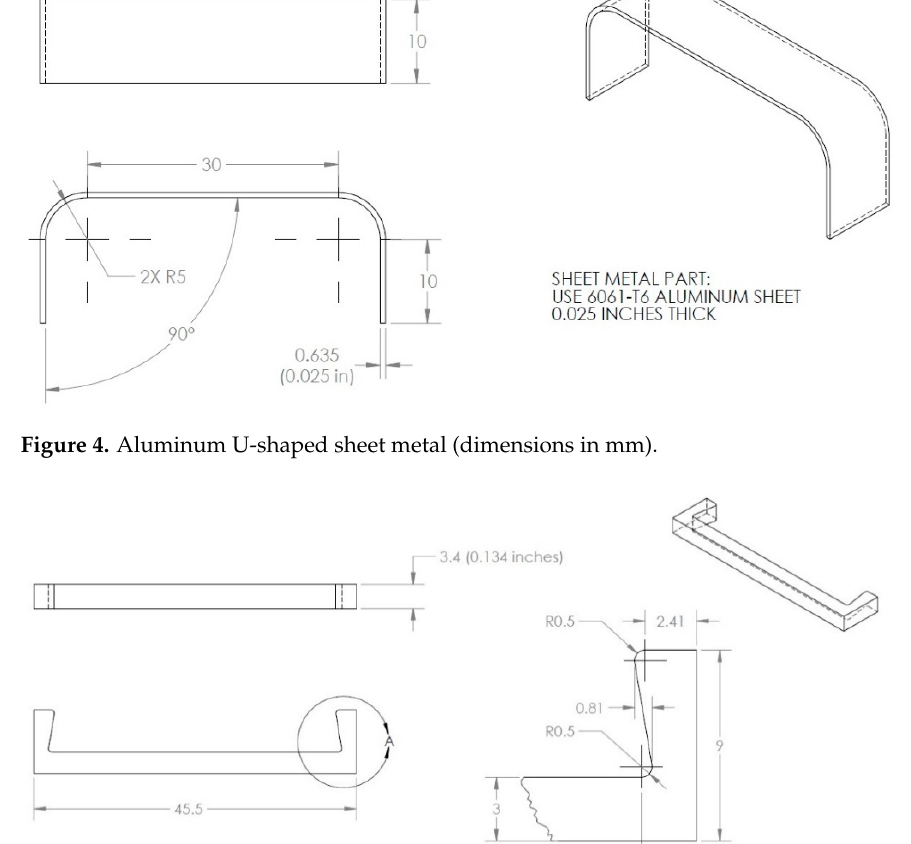
Figure 3. ( a ) Actual corrosion sensor; ( b ) corrosion sensor CAD model.